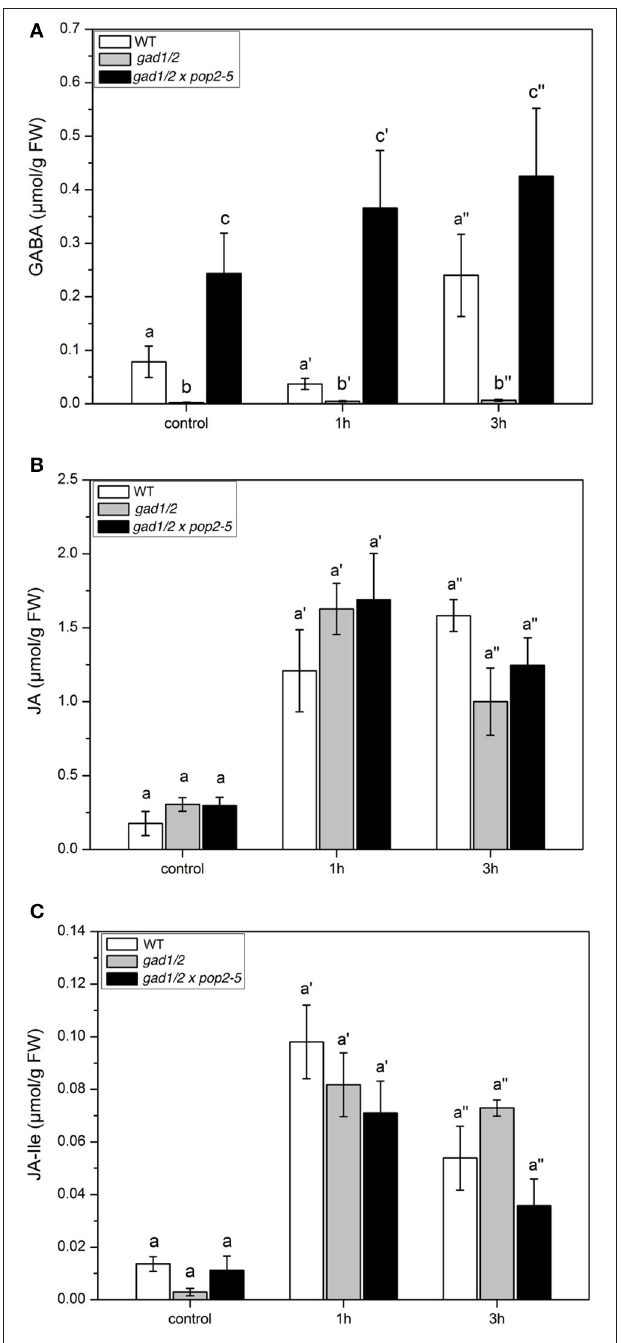
FIGURE 6 | GABA and Jasmonate levels upon MecWorm treatment in Arabidopsis wild-type (WT), gad1/2 and gad1/2 x pop2-5 plants. Mean ( ± SE, n = 6 ) levels of GABA (A) , JA (B) , and JA-Ile (C) were determined in control plants and 3h after treatment (black). Hormone and GABA levels were measured only from treated leaves. Untreated leaves from untreated plants were used as controls. Statistically significant differences between hormones in different mutants were analyzed by One-way ANOVA ( p < 0.05 , SNK-test) and are indicated by different letters. Statistical significant differences between control and treated plants were analyzed by t -test, * P ≤ 0.05 , ** P ≤ 0.01 , *** P ≤ 0.001